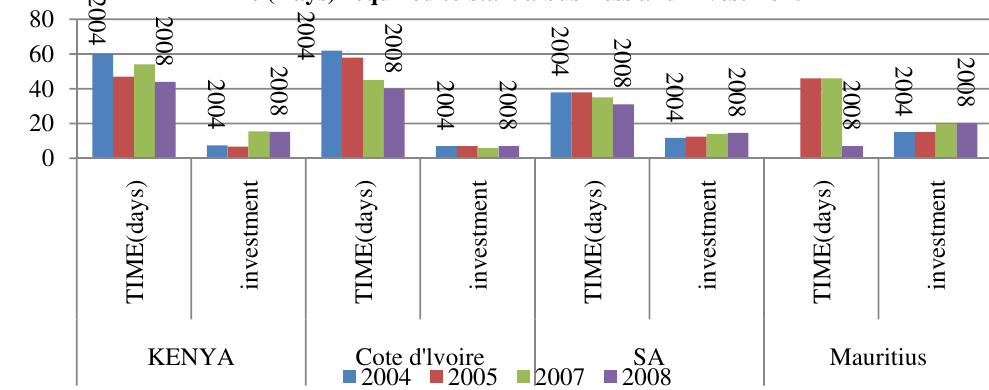
Fig. 10. Time required start a business and investment Source: authors’ computation.